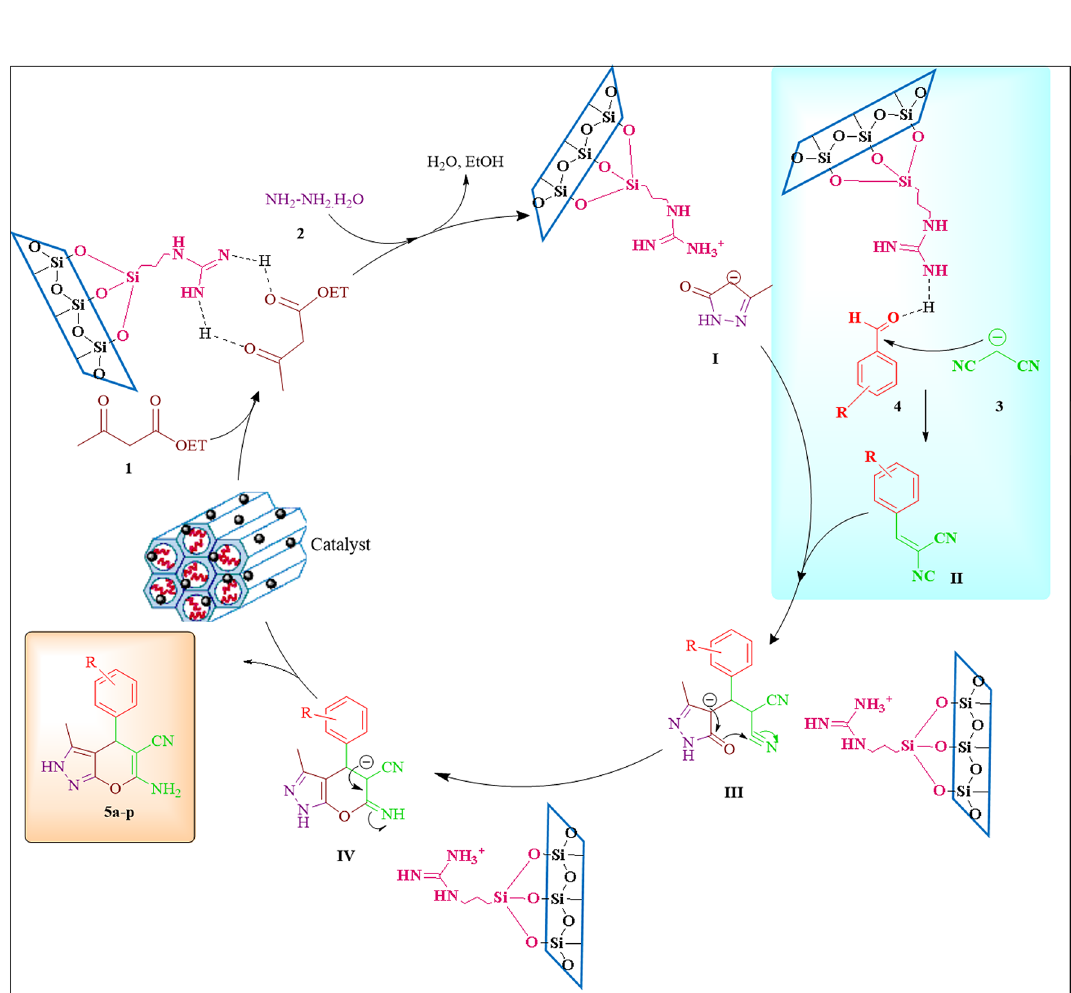
Figure 10. A suggested mechanism for the synthesis of pyrano[2,3-c]pyrazole derivatives catalyzed by the guanidinylated